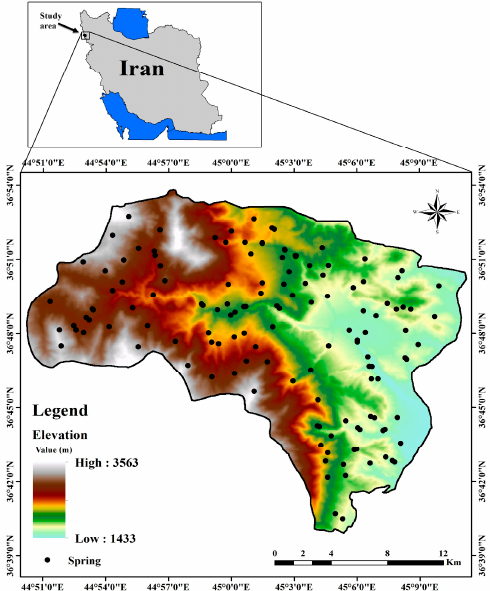
Figure 1. Map of the study area in north-western Iran, showing the 141 spring locations used in the present study.